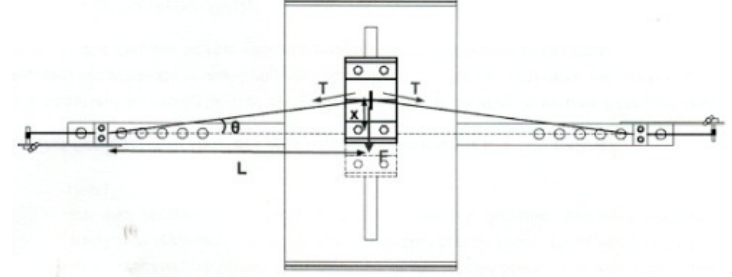
Figure 1. Physical model of the archetypal oscillator [23].